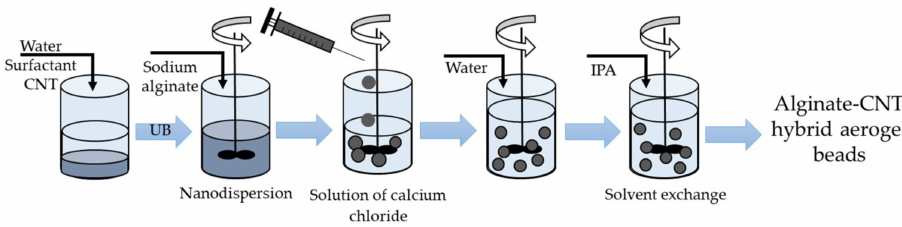
Figure 2. Synthesis of alginate–CNT hybrid aerogel beads. IPA is isopropyl